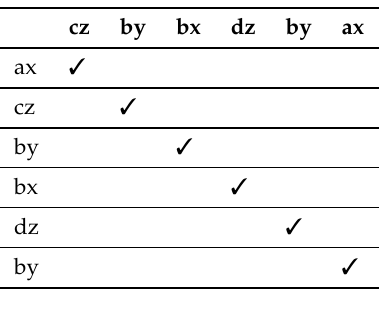
Table 17. MR-I results for chainPrecedence constraints (activation and